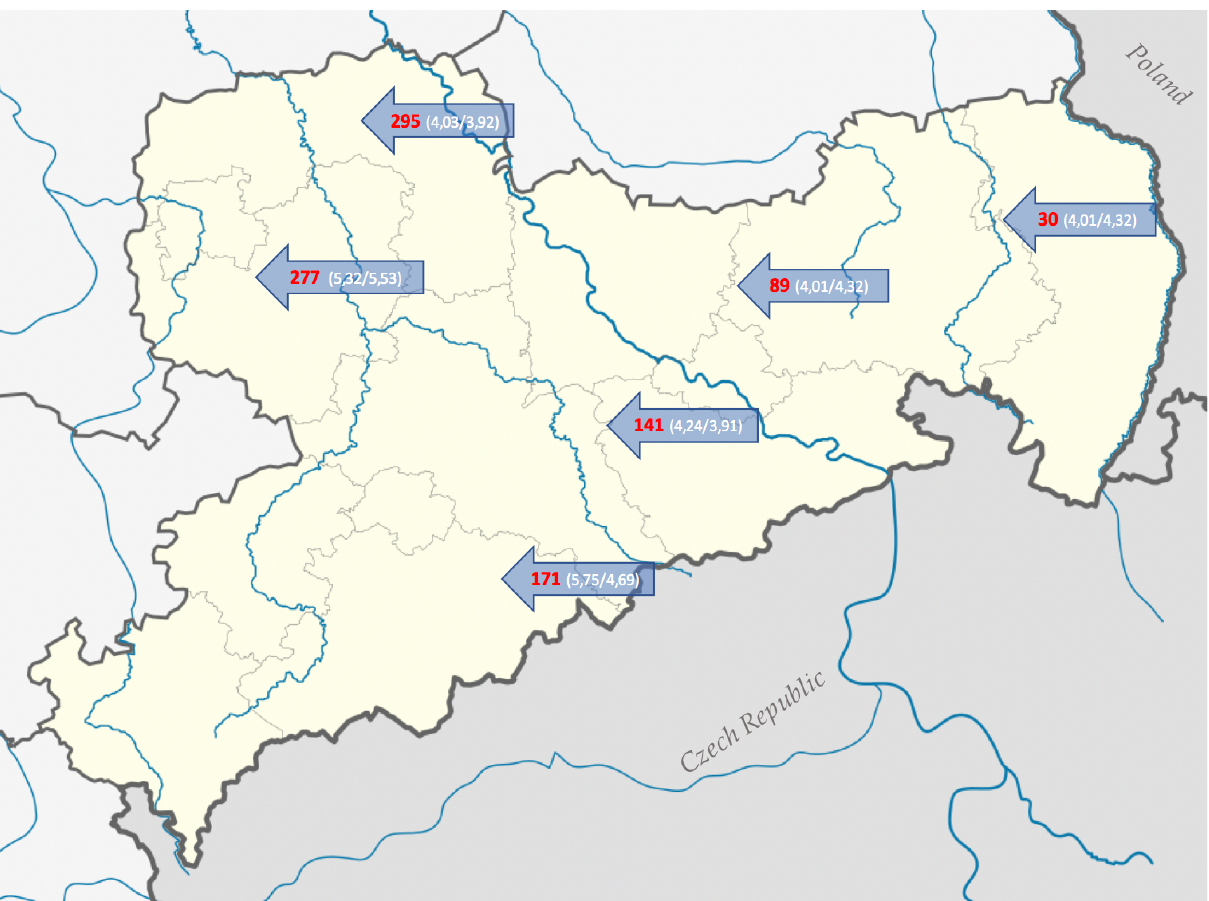
Figure 1. Collection spots of the soil samples. Official names by the authority of Sachsenforst, Pirna, Germany (arrows, red), the numbers in brackets describe the pH of top soil (first number) and mineral soil (second number). Forest stand of soil 277 and 89 is deciduous forest, of 171 and 141 spruce forest and of 295 and 30 pine forest. Map credit [18] (Original Author: TUBS; license link: https: